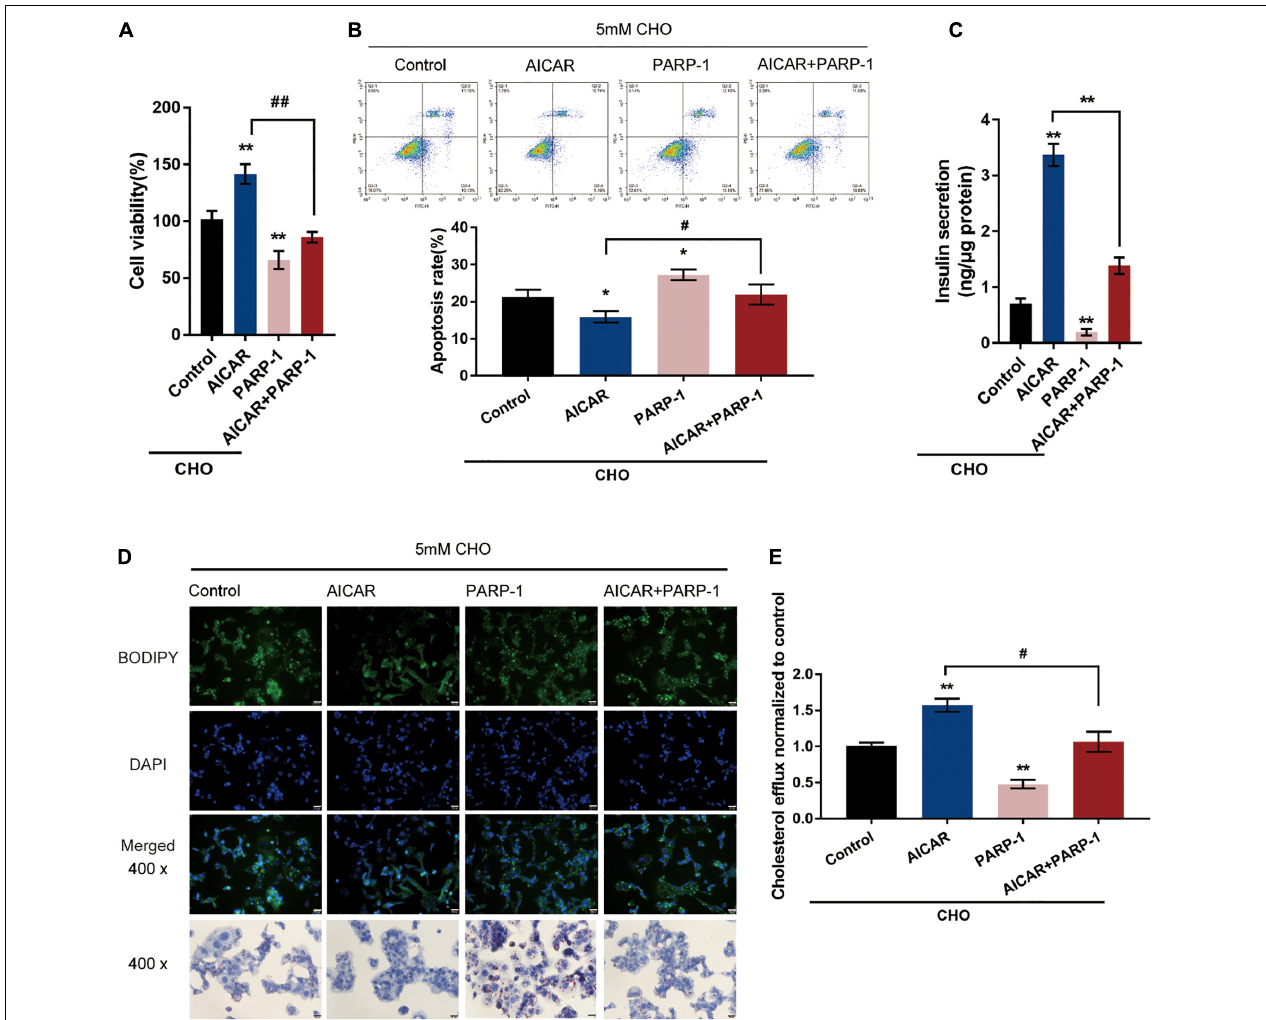
FIGURE 4 | AMPK inhibits PARP1 activity to attenuate cholesterol-induced toxicity. Cholesterol-stimulated INS-1 cells were treated with AICAR or PARP-1 alone or co-treated with AICAR and PARP-1 and examined for (A) cell viability by MTT assay; (B) cell apoptosis by Flow cytometry; (C) insulin secretion by insulin ELISA kit; (D) intracellular lipid deposition by Oil Red O and BODIPY staining. (E) The cholesterol efflux from INS-1 cells by BODIPY-cholesterol assay. * P < 0.05, ** P < 0.01 compared with control group, # P < 0.05, ## P < 0.01 compared with AICAR